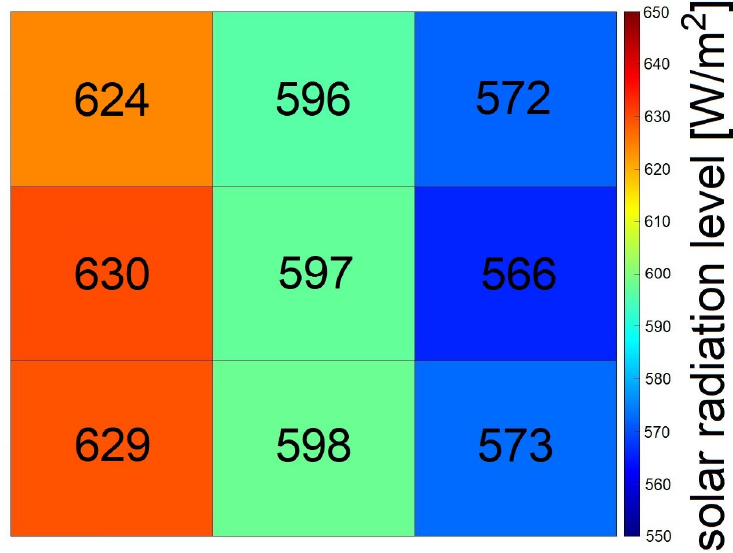
Figure 25. Average solar radiation levels obtained by individual sensor units.